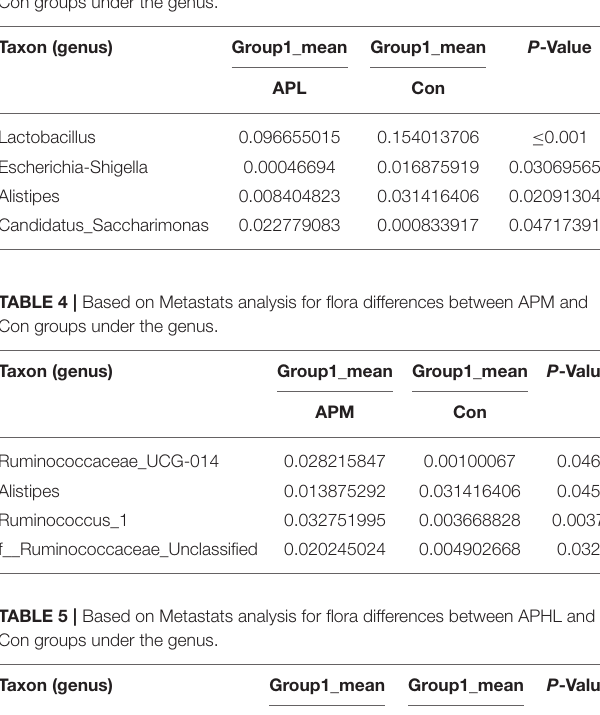
TABLE 8 | Based on Metastats analysis for flora differences between AMXH and Con groups under the genus.